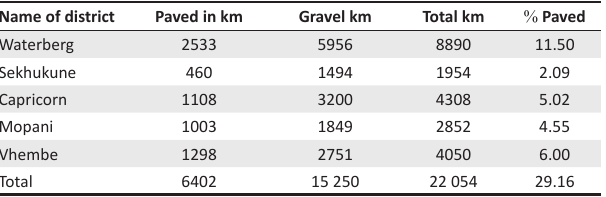
TABLE 1: Kilometres of road maintained per district in Limpopo province in